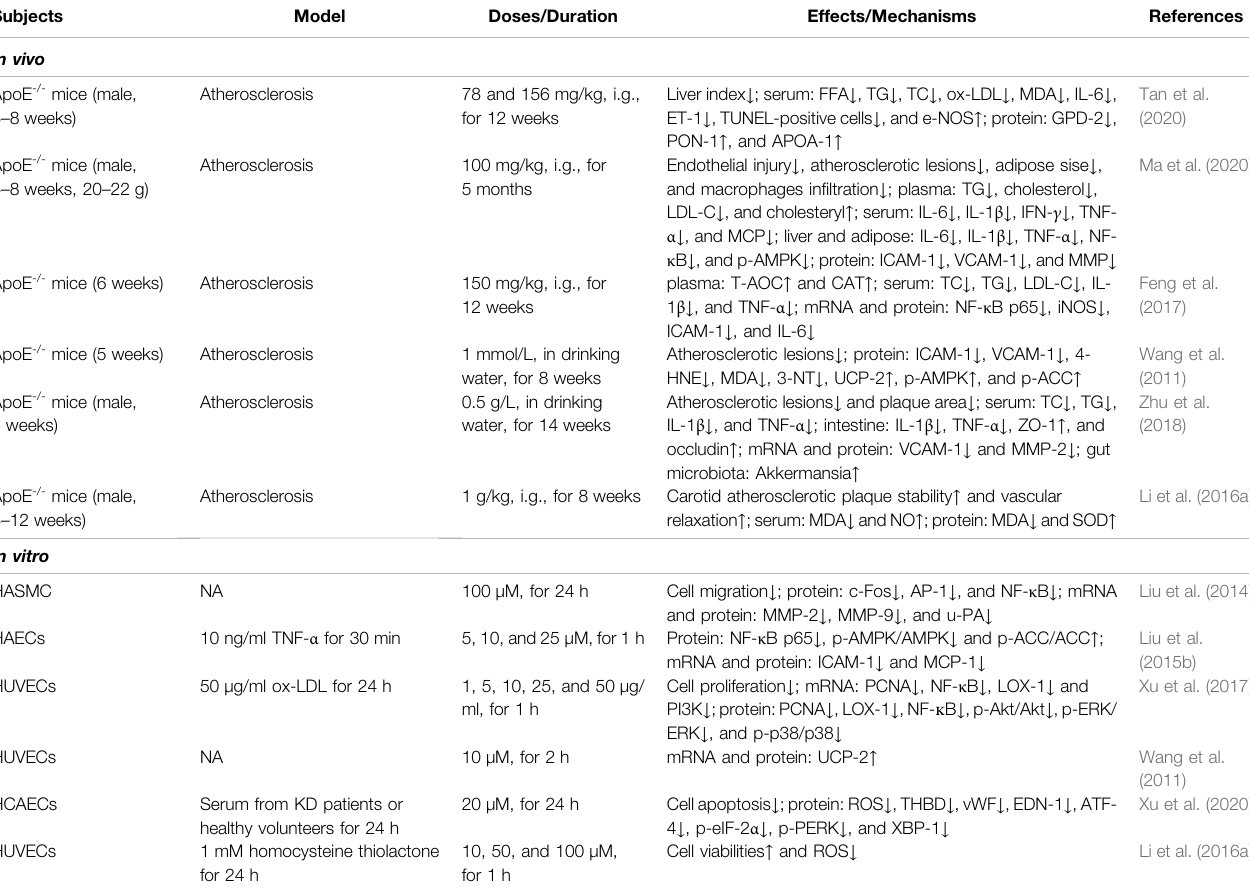
TABLE 2 | Pharmacological properties of berberine in